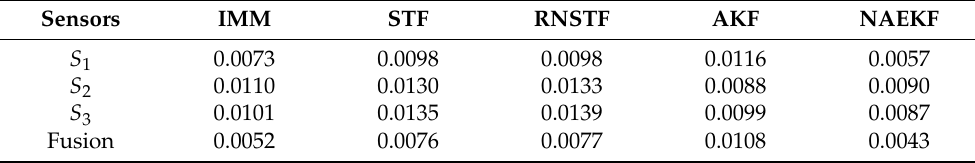
Table 6. Estimation errors of the azimuth angle ( ◦